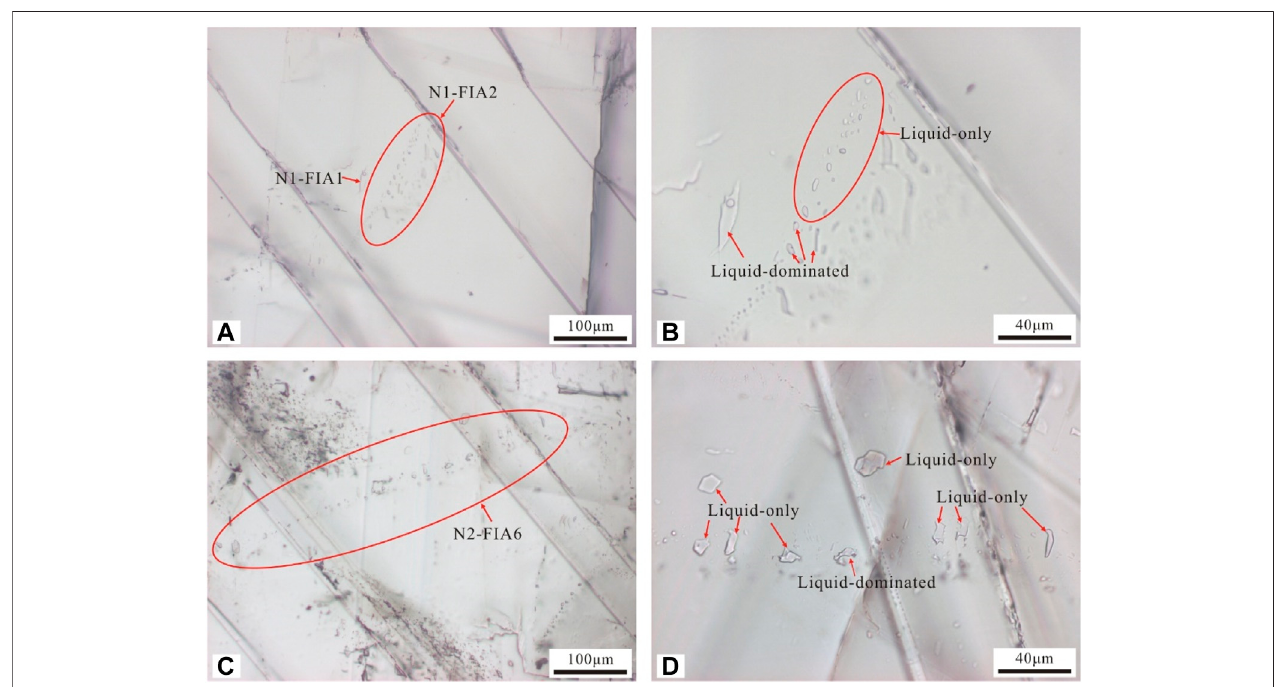
FIGURE 5 | The petrographic characteristics of fl uid inclusions in CFC. (A,B) Liquid-dominated and liquid-only aqueous inclusions coexisting in trails N1, TS3, 6,100.32 m, O 1-2 y . (C,D) Liquid-dominated and liquid-only aqueous inclusions coexisting in trails N2, TS3, 6,100.32 m, O 1-2 y